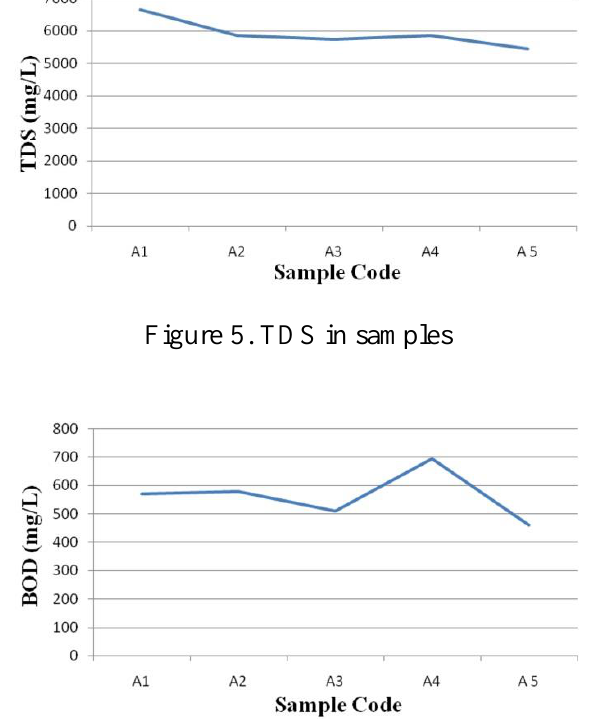
Figure 6. BOD of samples